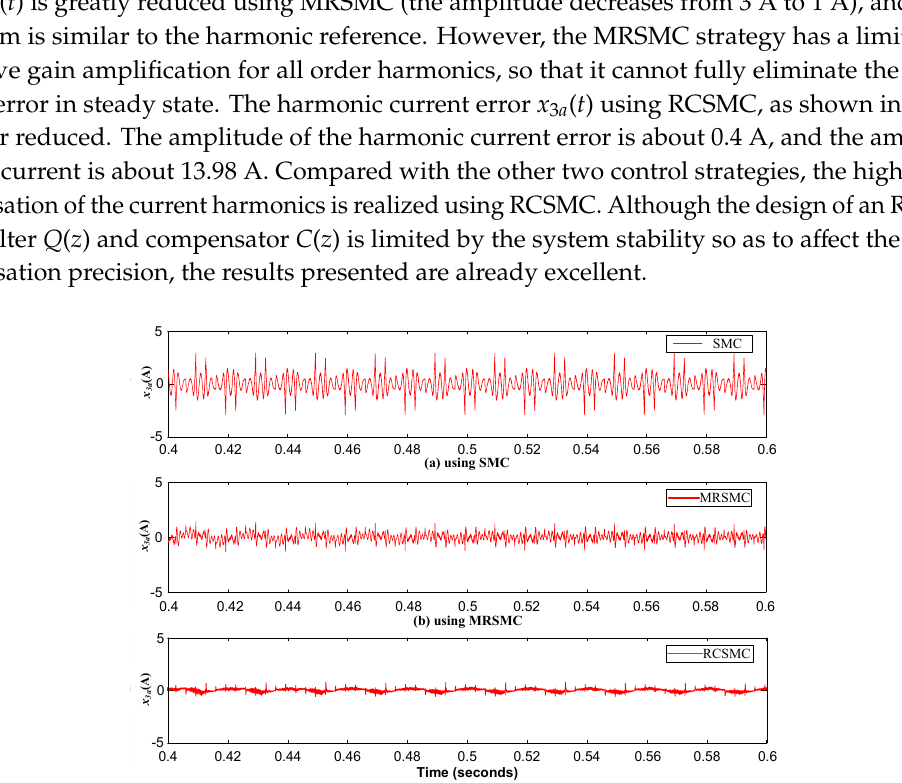
Figure 7. Simulation waveform of SAPF based on RCSMC in steady state.